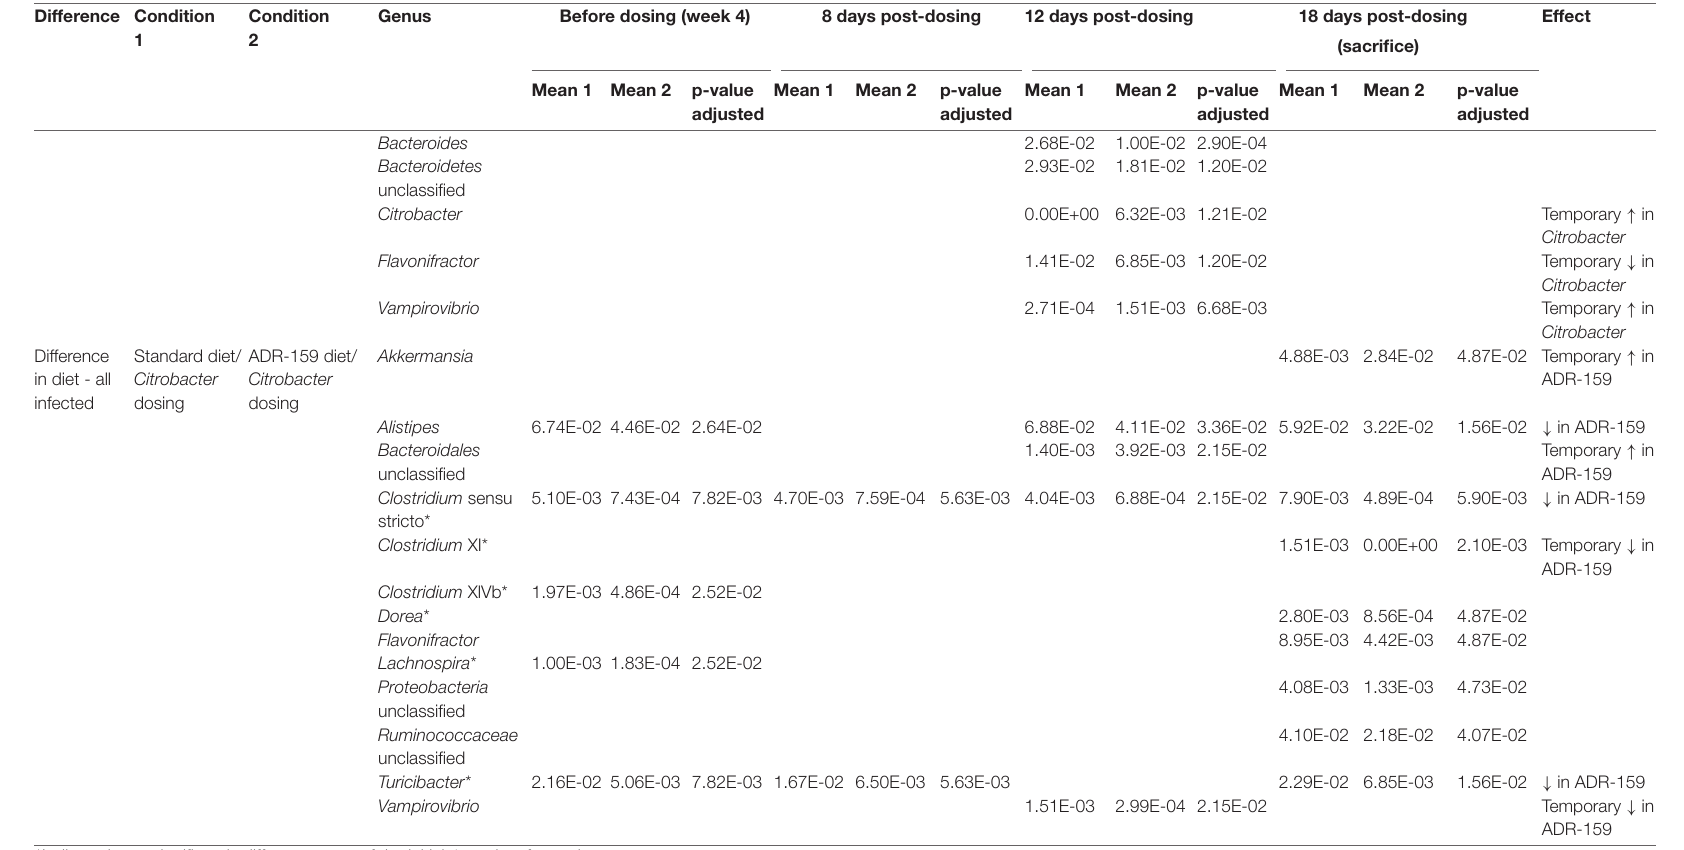
*Indicated taxa significantly different at one of the initial 4 weeks of